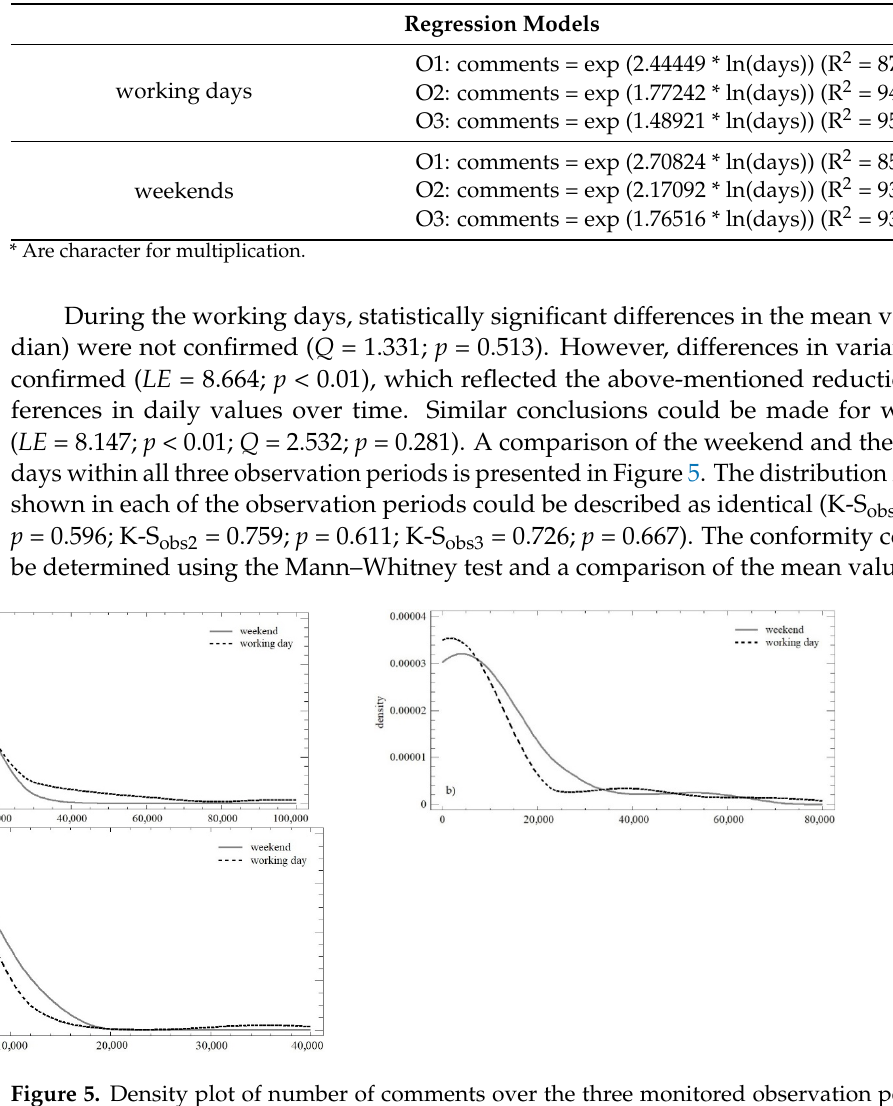
Table 3. Linear regression model for comments during working days and weekends in each observation.